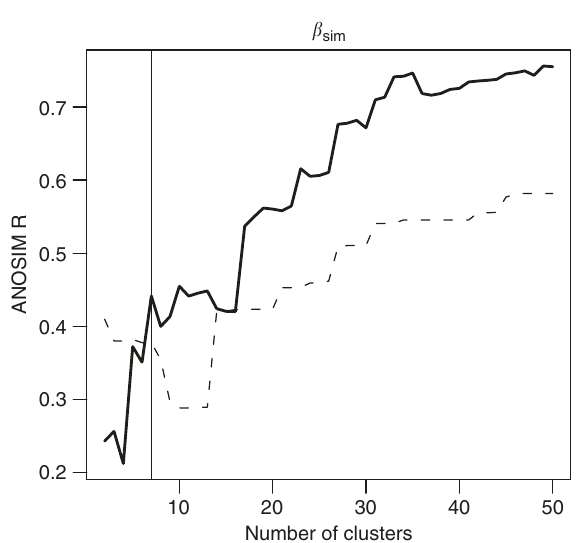
Fig. 1 ANOSIM R values against the number of clusters in which the dendrogram is cut. The dendrogram was built using Simpson dissimilarity ( β sim ) between cells and Ward (solid line) or average (dashed line) clustering. The vertical grey line marks the number of clusters ( n = 7) for which an increment does not yield relevant